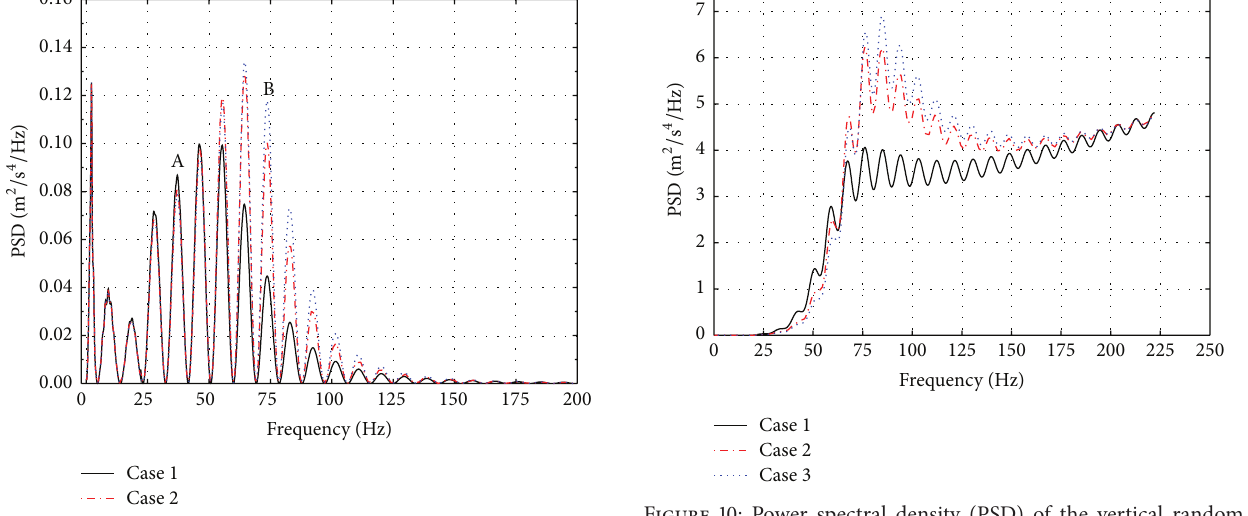
Figure 10: Power spectral density (PSD) of the vertical random vibration acceleration of a steel rail due to the linear secant stiffness, the nonlinear frequency-dependent stiffness, and the nonlinear amplitude- and frequency-dependent stiffness of rail